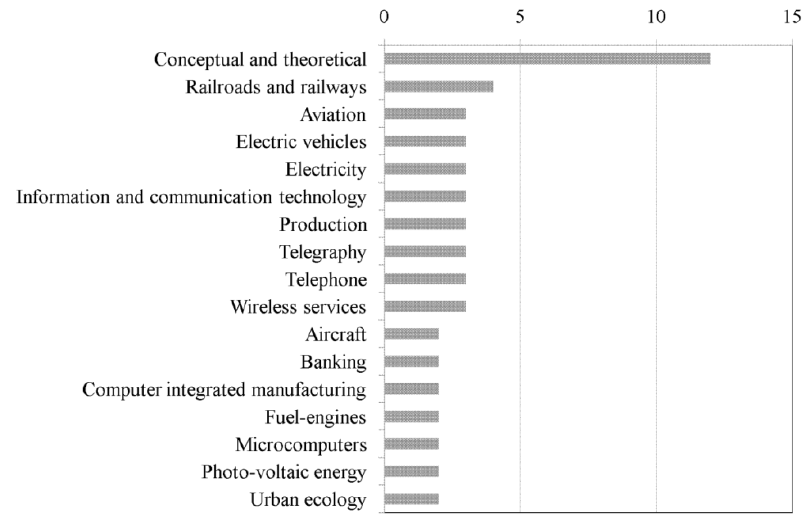
Figure 3. “Citations of the reverse salient concept in journals”.